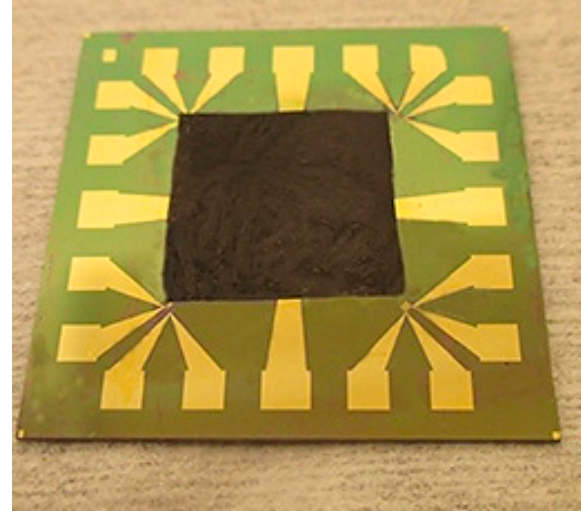
Figure 10. Temperature monitoring on thermal test chip with and without a monolayer graphene heat spreader. Replotted data sourced from Reference [34].